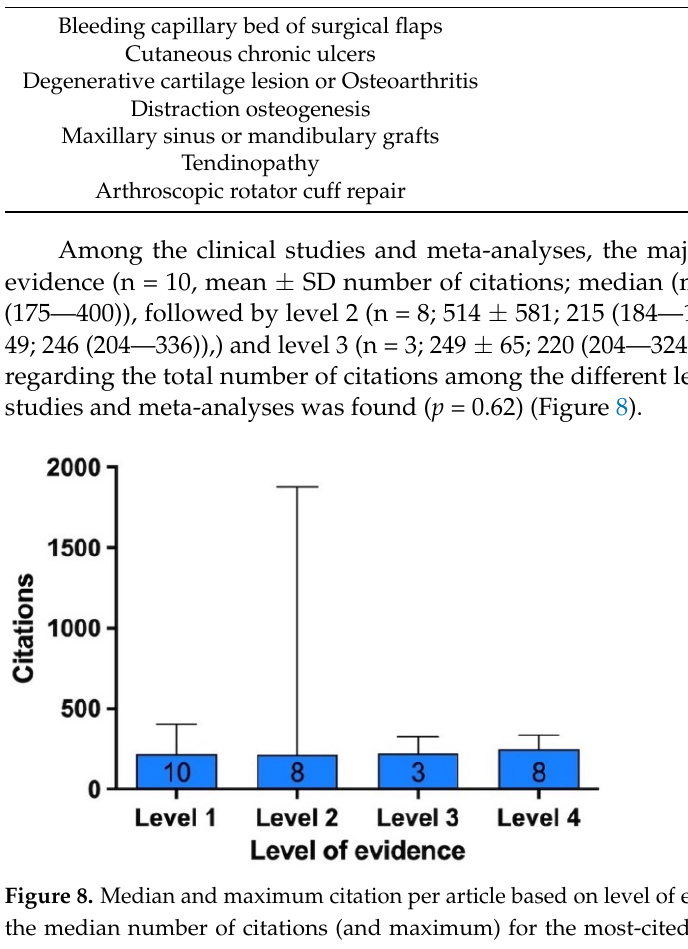
evidence of articles (number of articles at the bottom of the